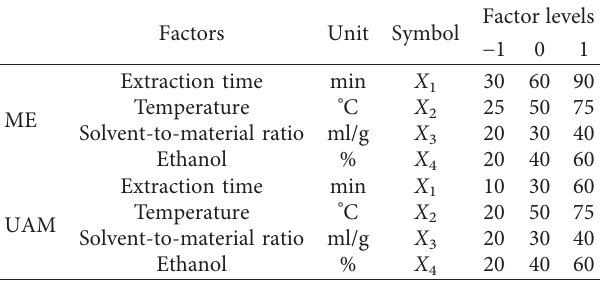
Table 2: The selected factors and their levels in the CCD